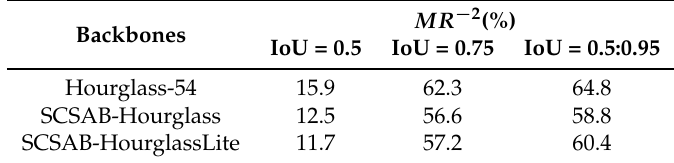
Table 2. The experimental results of different backbone networks in